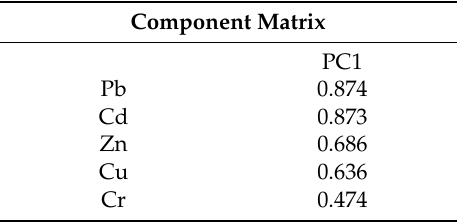
Table 12. Principal component analysis